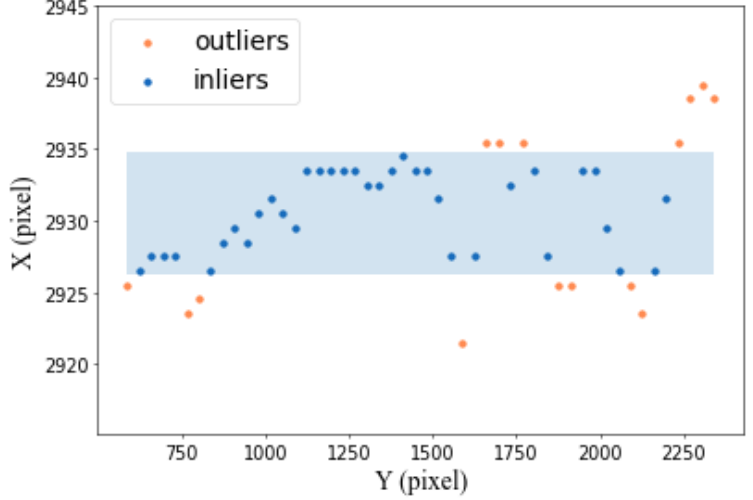
Figure 11. Distribution of feature point data in the image coordinate system.